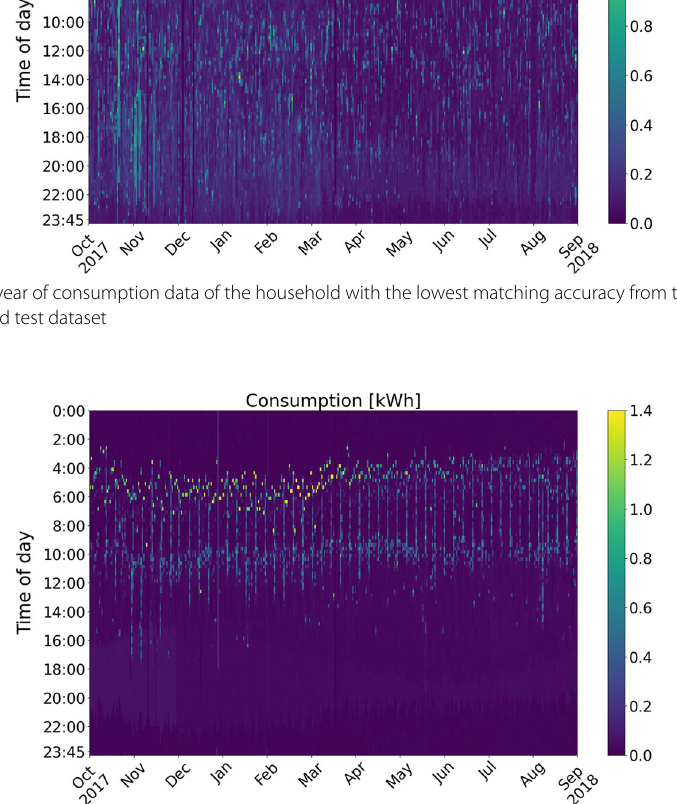
Fig. 7 One year of consumption data of the household with the highest matching accuracy from the 100-household test